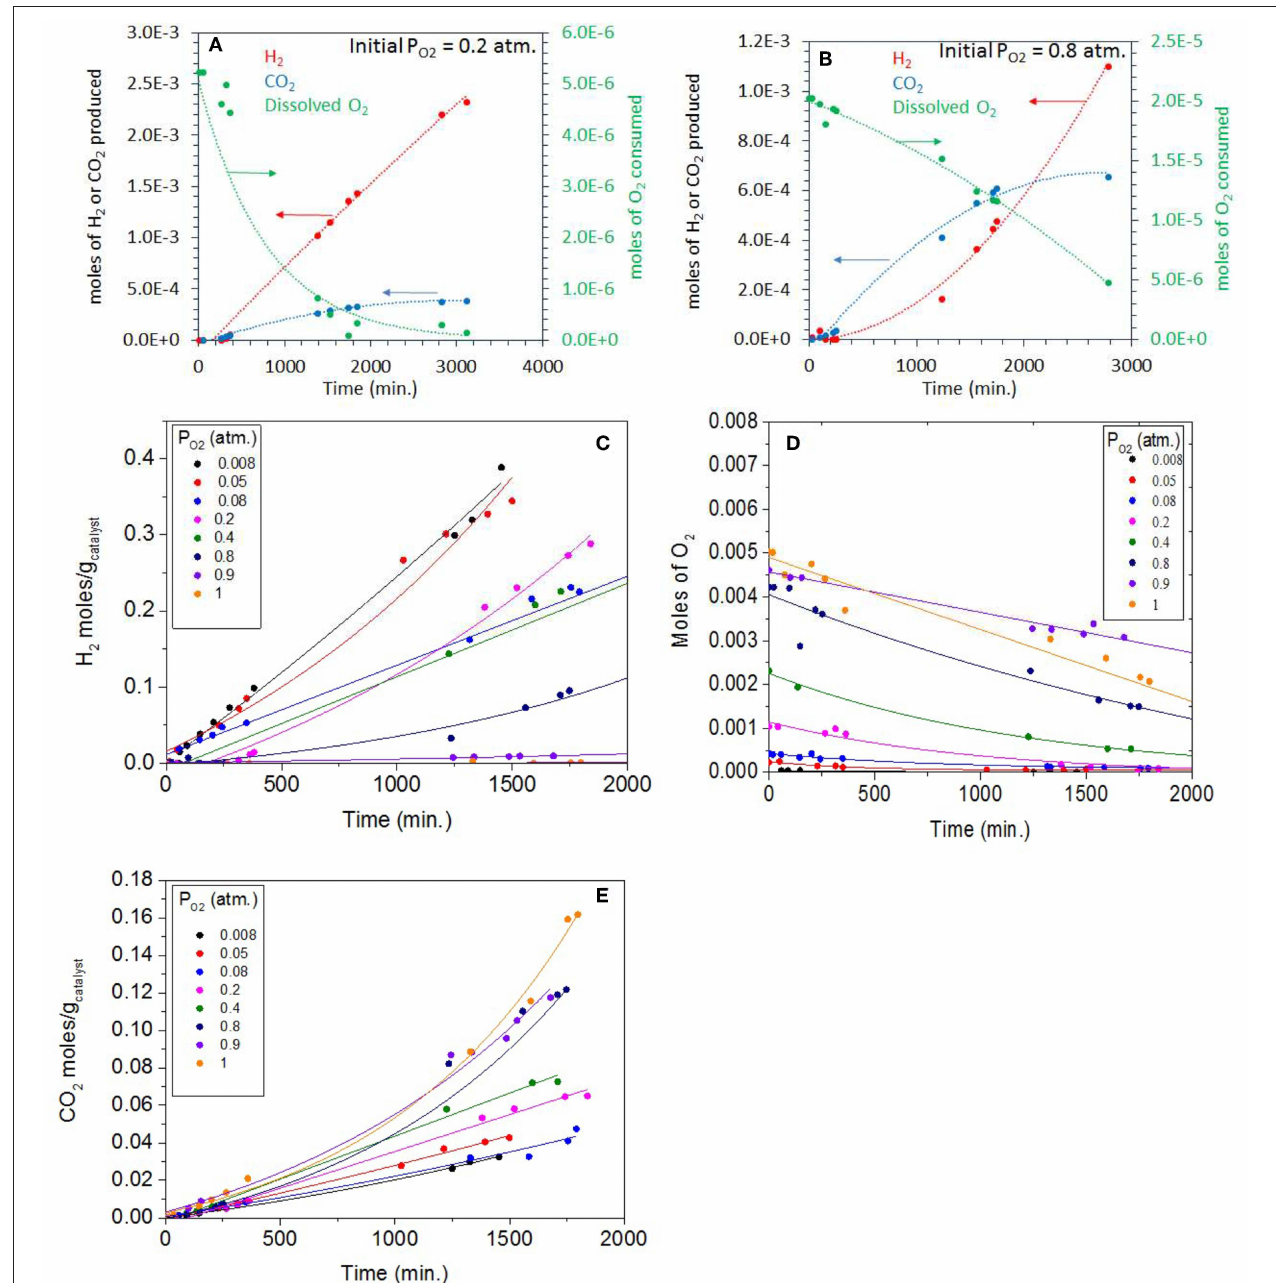
FIGURE 6 | (A) Photoreaction performed at 0.20 atm P O2 with 0.5 vol.% (0.067M) ethylene glycol and 5mg of 0.1 wt.% Ag-0.3 wt.% Pd/TiO 2 (anatase) catalyst. (B) Photoreaction performed at 0.8 atm P O2 with 0.5 vol.% (0.067M) ethylene glycol and 5mg of 0.1 wt.% Ag − 0.3 wt.% Pd/TiO 2 (anatase) catalyst. (C) H 2 production during the Photoreaction at 0.008 to 1 atm P O2 with 0.5 vol.% (0.067M) ethylene glycol and 5mg of 0.1 wt.% Ag − 0.3 wt.% Pd/TiO 2 (anatase) catalyst. (D) Decrease in O 2 concentration (gas phase) during the Photoreaction at 0.008–1 P O2 atm with 0.5 vol.% (0.067M) ethylene glycol and 5mg of 0.1 wt.% Ag − 0.3 wt.% Pd/TiO 2 (anatase) catalyst. (E) CO 2 production during the Photoreaction at 0.008–1 P O2 atm with 0.5 vol.% (0.067M) ethylene glycol and 5mg of 0.1 wt.% Ag − 0.3 wt.% Pd/TiO 2 (anatase) catalyst.